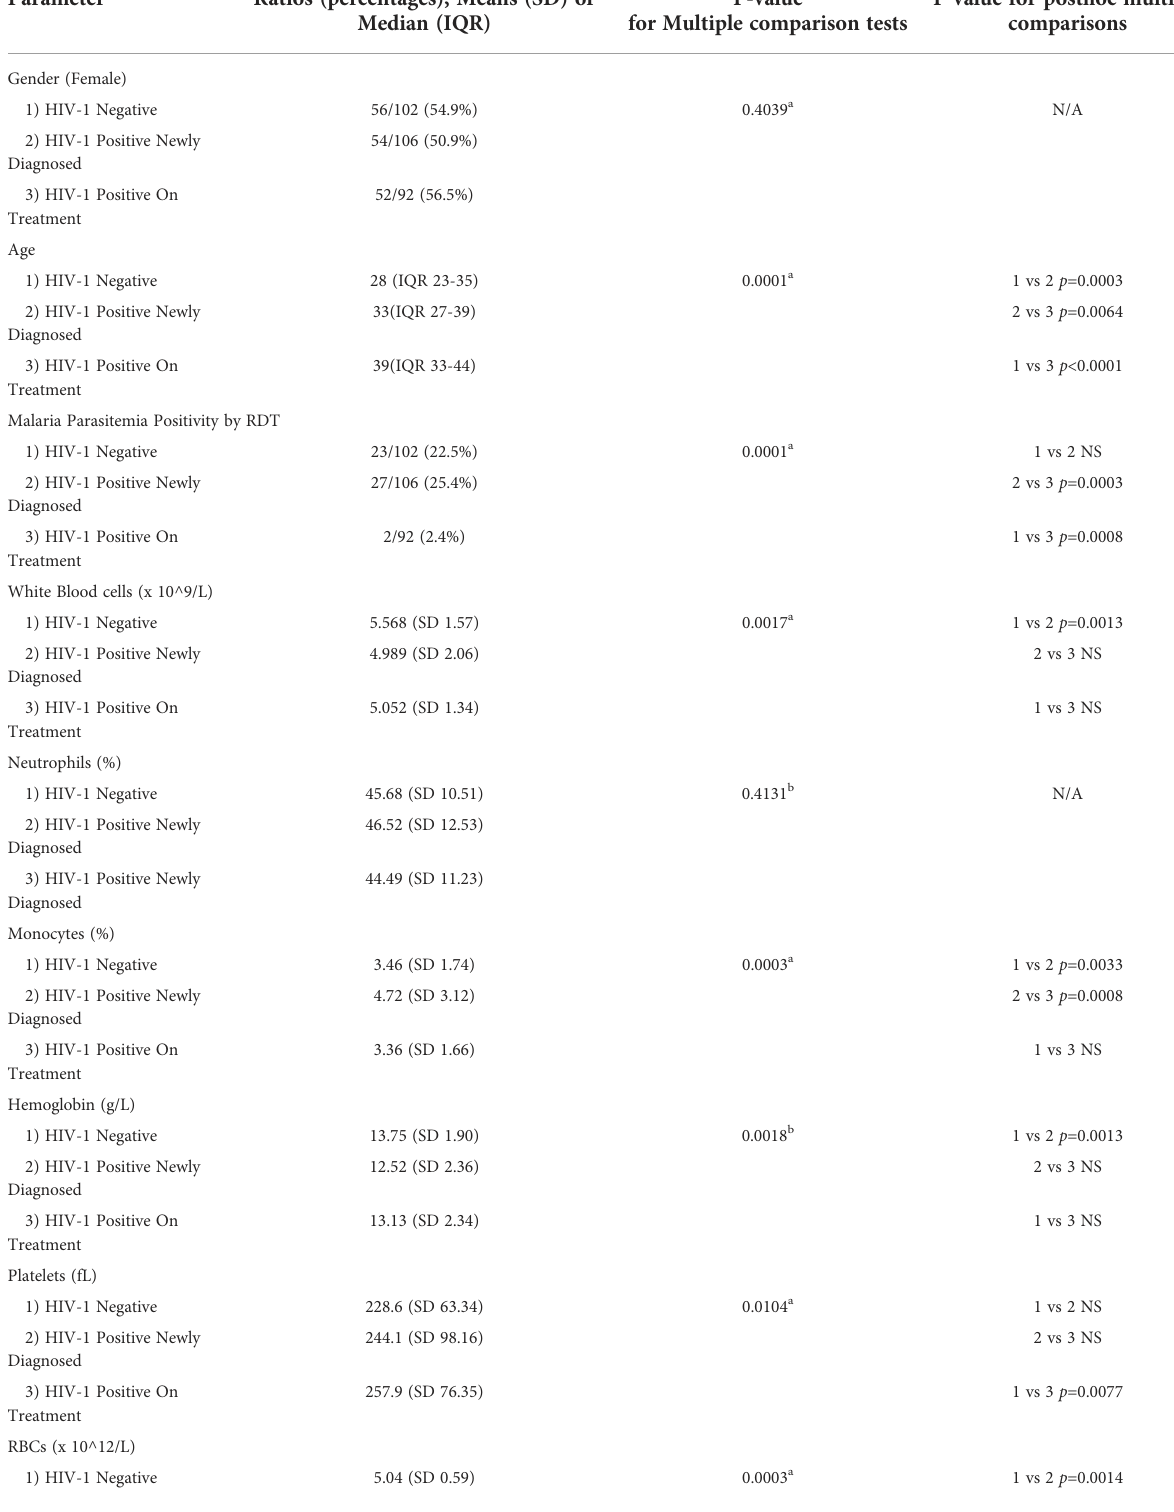
TABLE 1 Baseline characteristics of volunteers at